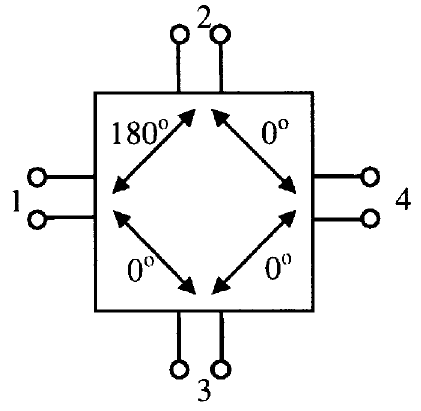
FIGURE 12 Ideal 180-deg